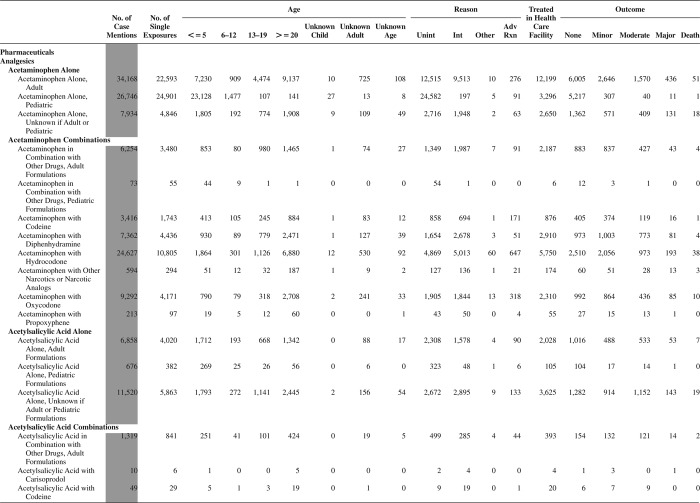
Demographic profile of SINGLE SUBSTANCE Pharmaceuticals exposure cases by generic category.